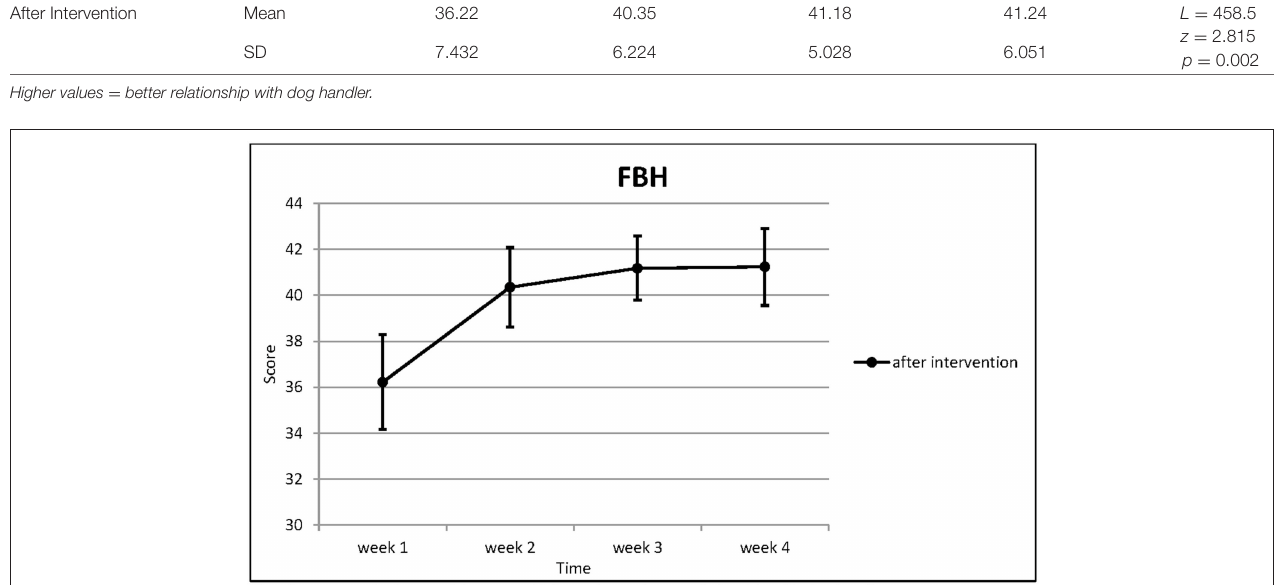
FIGURE 7 | Relationship with the Dog